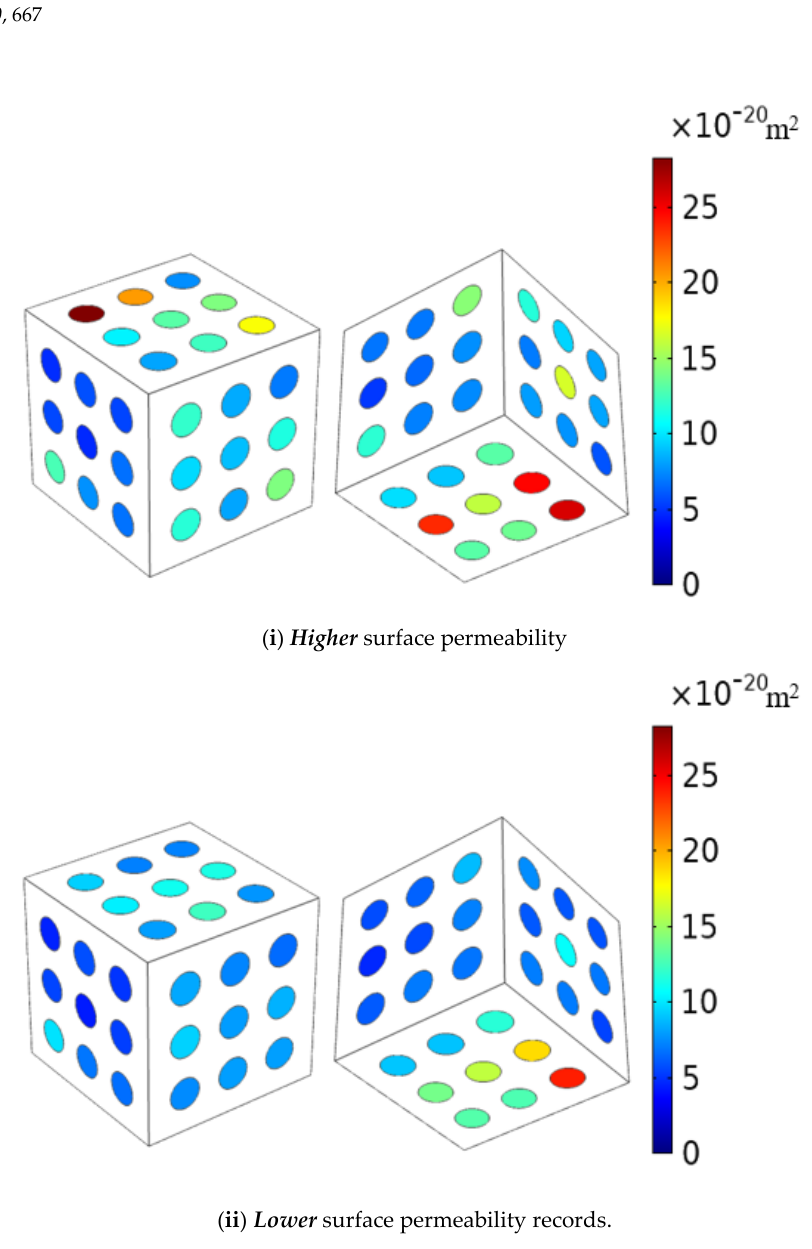
Figure 10. Surface permeability data for the Lac du Bonnet granite. records.